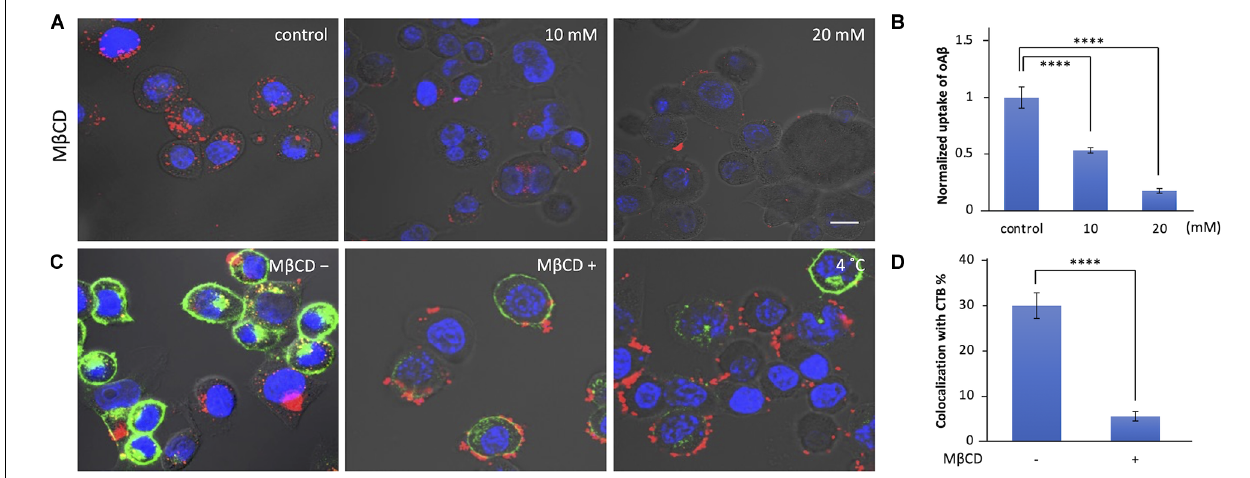
FIGURE 2 | Effect of lipid raft disruption with cyclodextrin on oA β 42 uptake. (A) Neuro2A cells were pretreated with M β CD (10 or 20 mM) for 30 min at 37 ◦ C; then, the cell culture medium was exchanged with that with 5 µ M oA β 42 and incubated for 90 min at 37 ◦ C. Nuclei were visualized with Hoechst 33342 (blue). (B) Quantification of the fluorescence intensity shows the uptake of oA β 42, and data are presented as mean fluorescence normalized to control. Significance was established using ANOVA followed by the Dunnett–Square test. Data are presented as mean ± SEM. All experiments were repeated three times. (C) Neuro2A cells were incubated with or without 10 mM M β CD for 30 min at 37 ◦ C, followed by incubation with 20 µ g/ml CTB for 10 min at 4 ◦ C. Subsequently, cells were further incubated at 37 ◦ C for 90 min in combination with oA β 42 (5 µ M). Alternatively, Neuro2A cells were pretreated with 5 µ M oA β 42 and 20 µ g/ml CTB at 4 ◦ C for 10 min, and then at 37 ◦ C for 90 min. (D) Quantification of the colocalization of oA β 42 and CTB (colocalization/total) in the absence or presence of M β CD (10 mM). All experiments were repeated three times. Data are presented as mean ± SEM. Significance was established by Student’s t-test. Scale bars = 10 µ m. ∗∗∗∗ p <